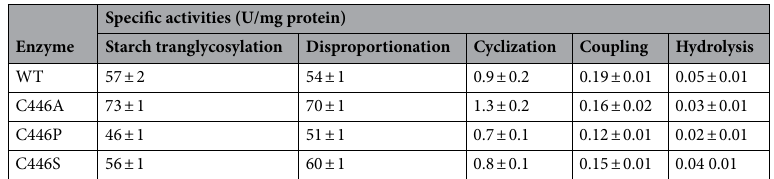
Table 3. Activities of WT and C446 mutated Sa AMs. Data are shown as the mean ± standard deviation and are derived from three independent experiments.